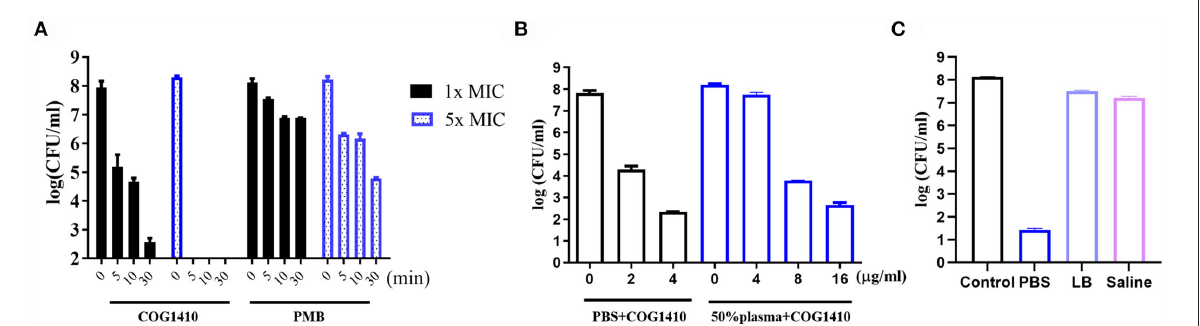
FIGURE1 Antimicrobial activity of COG1410. (A) In vitro killing kinetics of COG1410 and polymyxin B against PDR A. baumannii YQ4 in PBS at 1 × MIC and 5 × MIC, respectively. (B) Bactericidal efficacy of COG1410 in PBS with or without 50% human plasma. The CFU/ml was calculated after incubation at 37 ◦ C for 2h. (C) Bactericidal efficacy of COG1410 in different conditions was determined. PMB, polymyxin B. Each experiment was done in triplicate, and the values are represented as mean ±